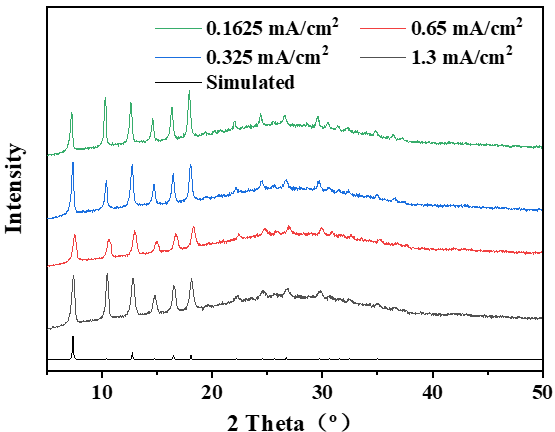
Figure 7. XRD patterns of ZIF-8/AAO membranes deposited for 60 min under different deposition currents.